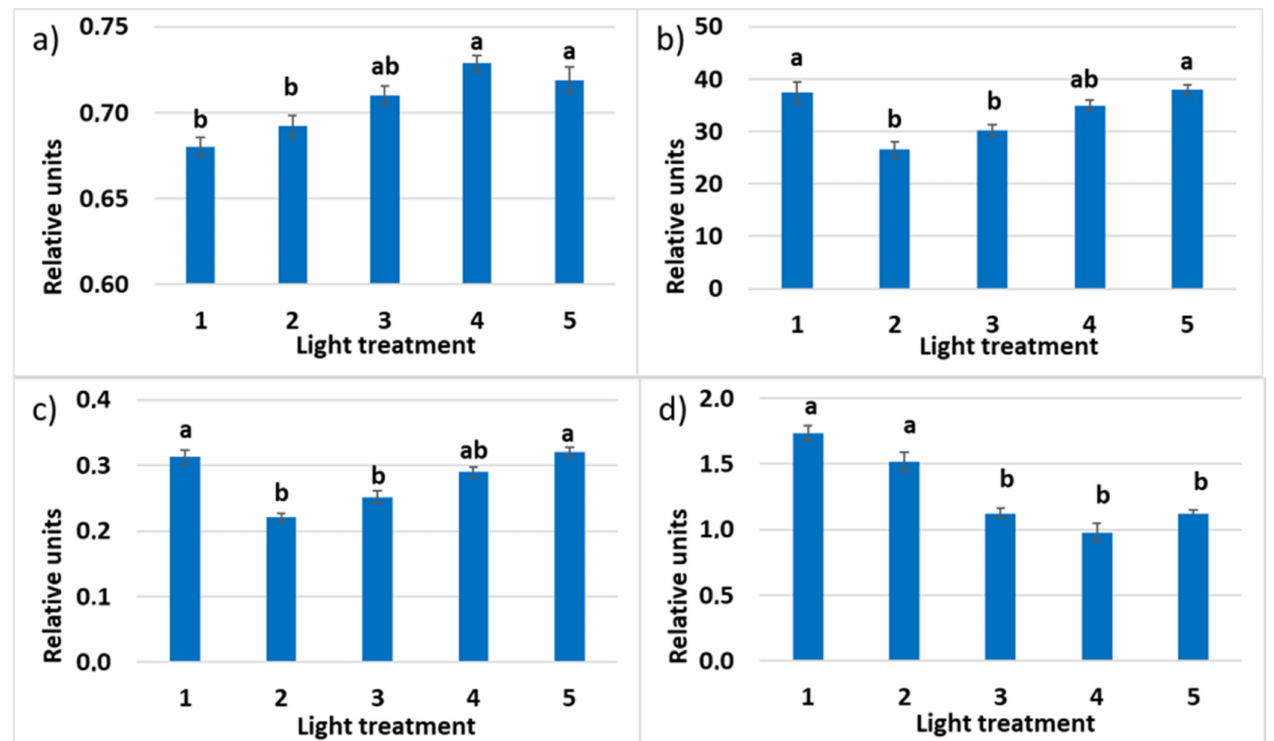
Figure 14. ( a ) Maximum quantum efficiency of PSII (Fv/Fm); ( b ) photochemical electron transport rate (ETR); ( c ) relative PSII operating efficiency ( Φ PSII); ( d ) chlorophyll a non-photosynthetic quenching (NPQ) in the leaves of raspberry plants grown under various red (R)–green (G)–blue (B) light ratio. Means ± standard error (SE); means followed by the same letter were not different at p ≤ 0.05. Treatment 1—50% R, 25% G, 25% B; Treatment 2—37% R, 26% G, 37% B; Treatment 3—24% R, 28% G, 48% B; Treatment 4—63% R, 16% G, 21% B; Treatment 5—46% R, 30% G, 23%